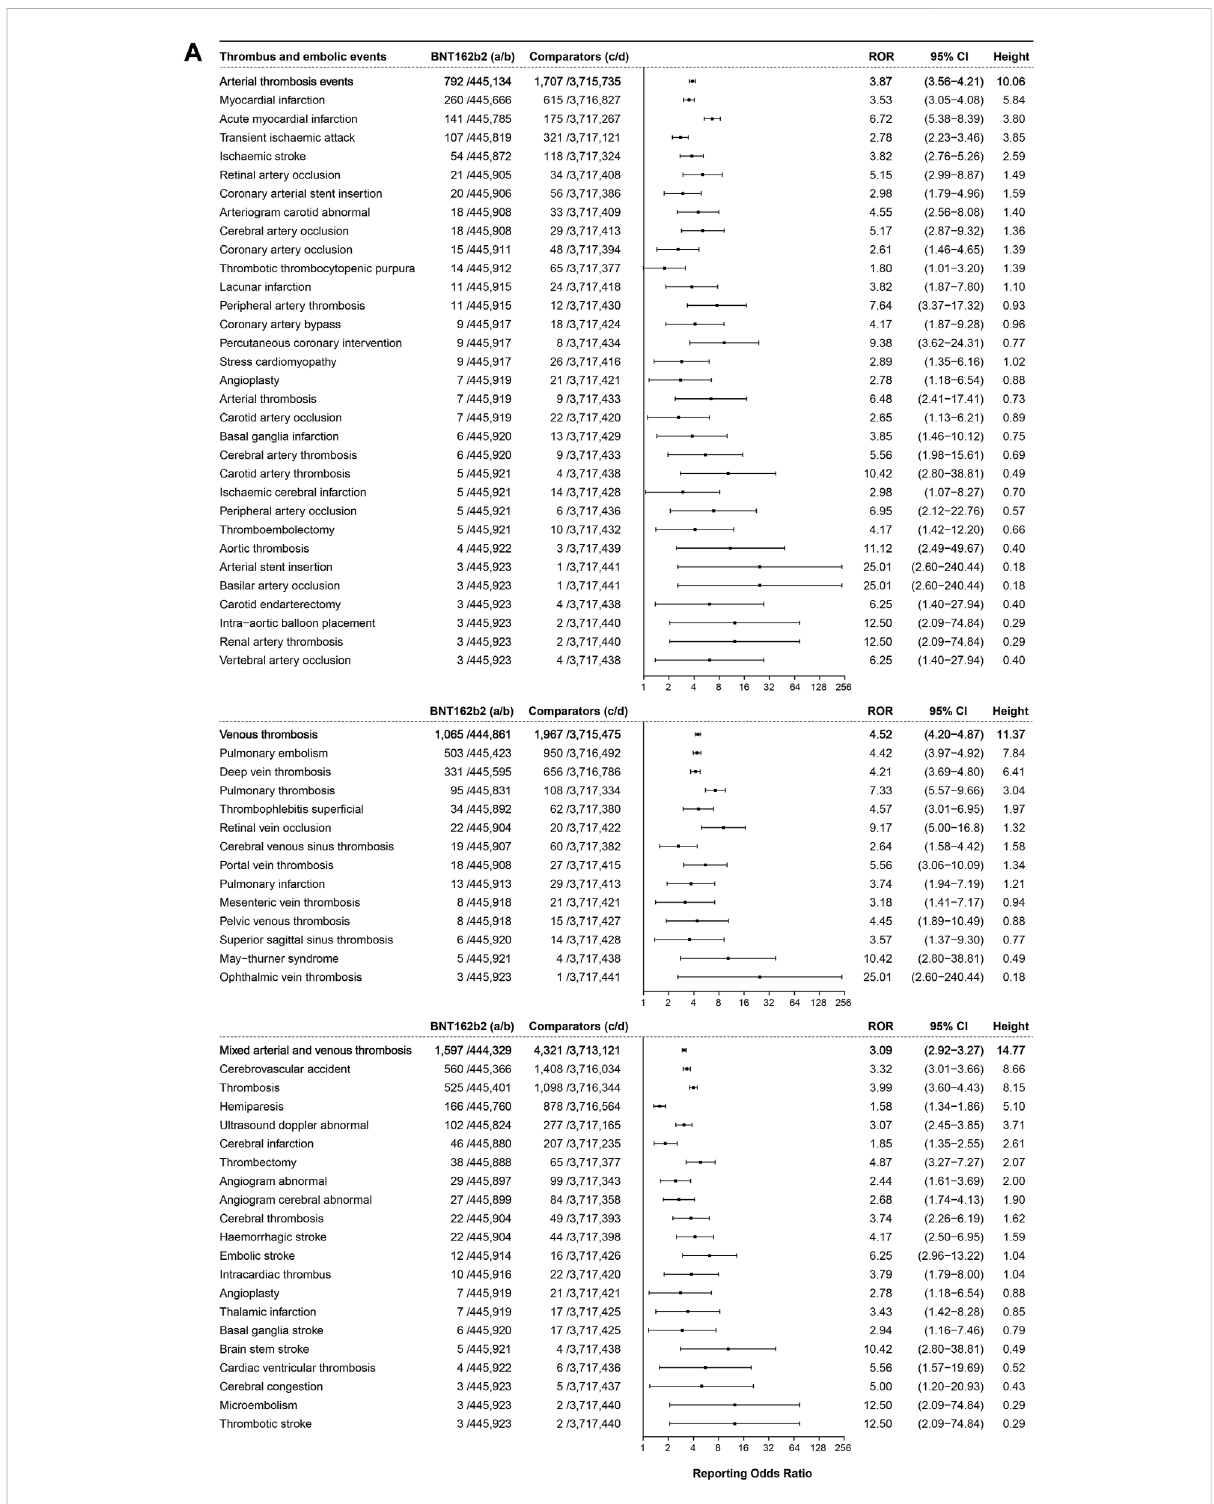
FIGURE 3 (A) RORvaluesandheightoftheCOVID-19vaccinesofBNT162b2-associatedthromboticevents.a:casesoftargetthromboticeventsreported concerning the BNT162b2 vaccine; b: cases of other adverse events reported concerning the BNT162b2 vaccine; c: cases of target thrombotic events reported concerning all the other vaccines; d: cases of adverse events reported concerning all the other